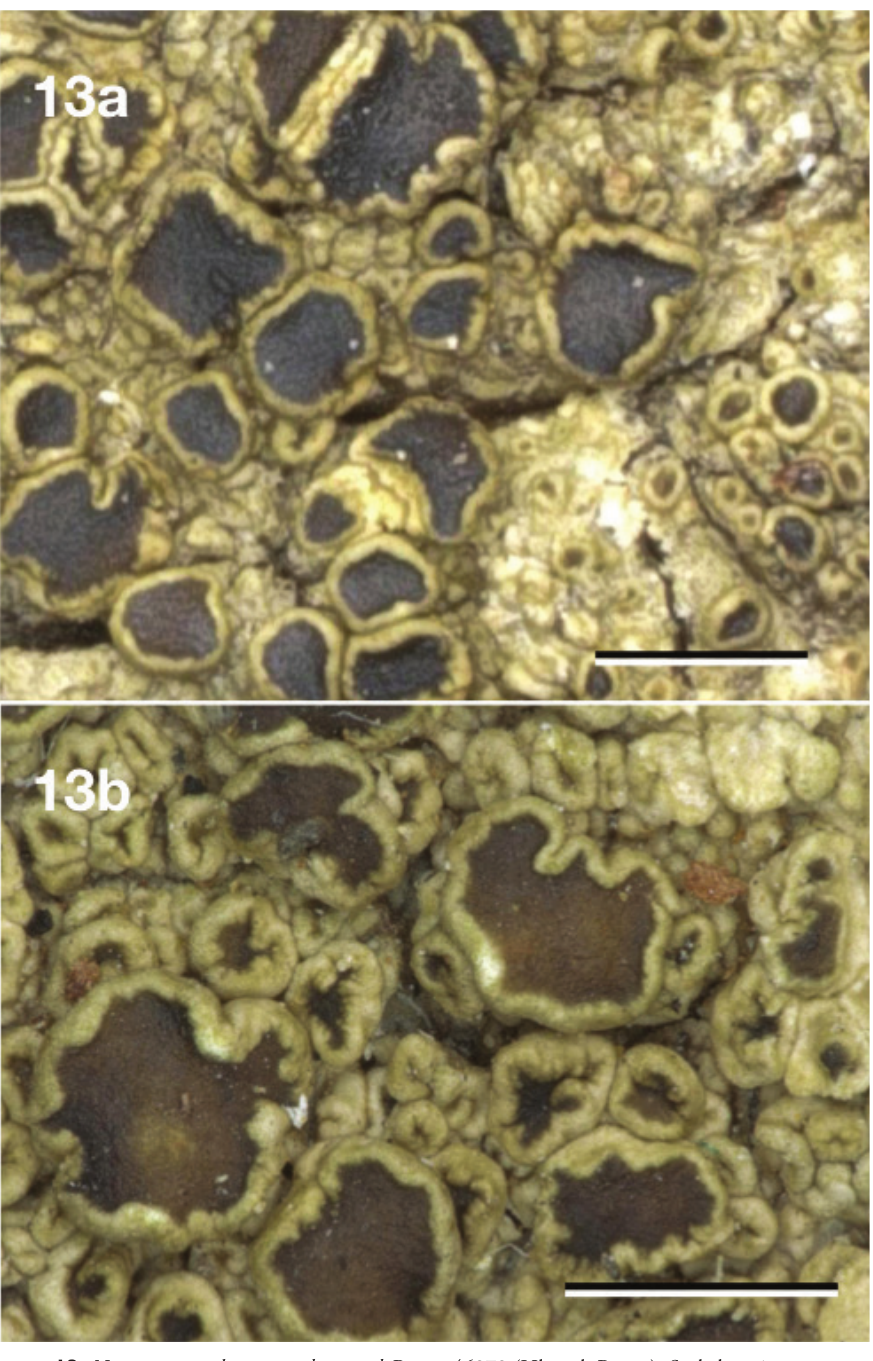
Figure 13. Neoprotoparmelia siamisidiata , v.d. Boom 46872 (Hb. v.d. Boom). Scale bar: 1